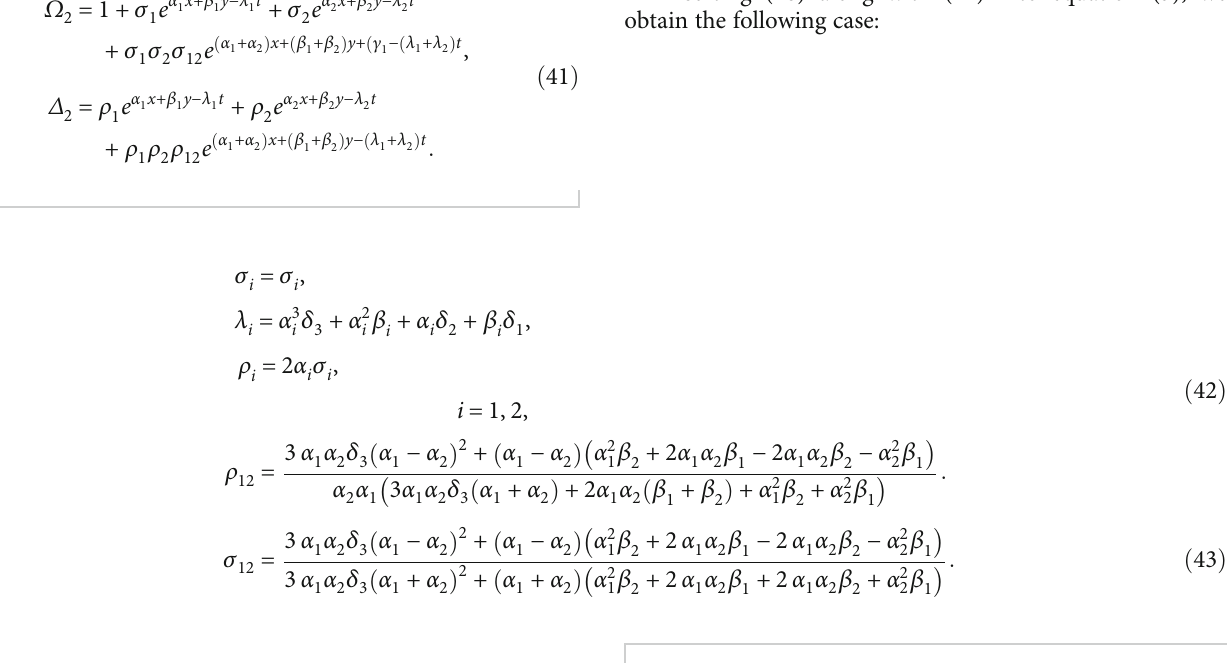
= 1, σ = 2, ρ = 2 : 2, ρ 1 1 1